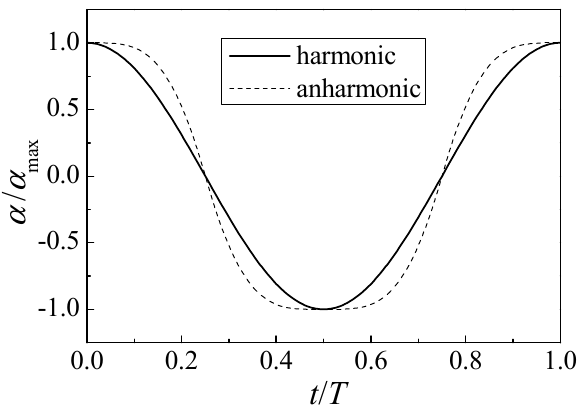
Figure 2. AoA comparison between the anharmonic and the simple harmonic motion when n = 1. When n is not an integer, its value can be obtained by linear interpolation, such as Then, according to the relationship between AoA α and pitching angle θ , the pitching angle curve can be obtained from Equation (3). It can be seen from the Equation (3), when the foil heave motion is defined, the pitching angle θ is related to the AoA α and the St number. To maintain the same pitching amplitude θ 0 for comparison, the AoA will vary with the St Number. Two St Numbers, 1/3 and 1/6.5, respectively, were chosen for the study, which correspond to the two cases of J = 3 and J = 6.5, presented in the Figure 3. The maximum pitching angle is kept constant and the AoA of the two conditions were defined using g 1 ( t ) function with maximum AoA equal to 0.50845 and 0.15022, respectively.